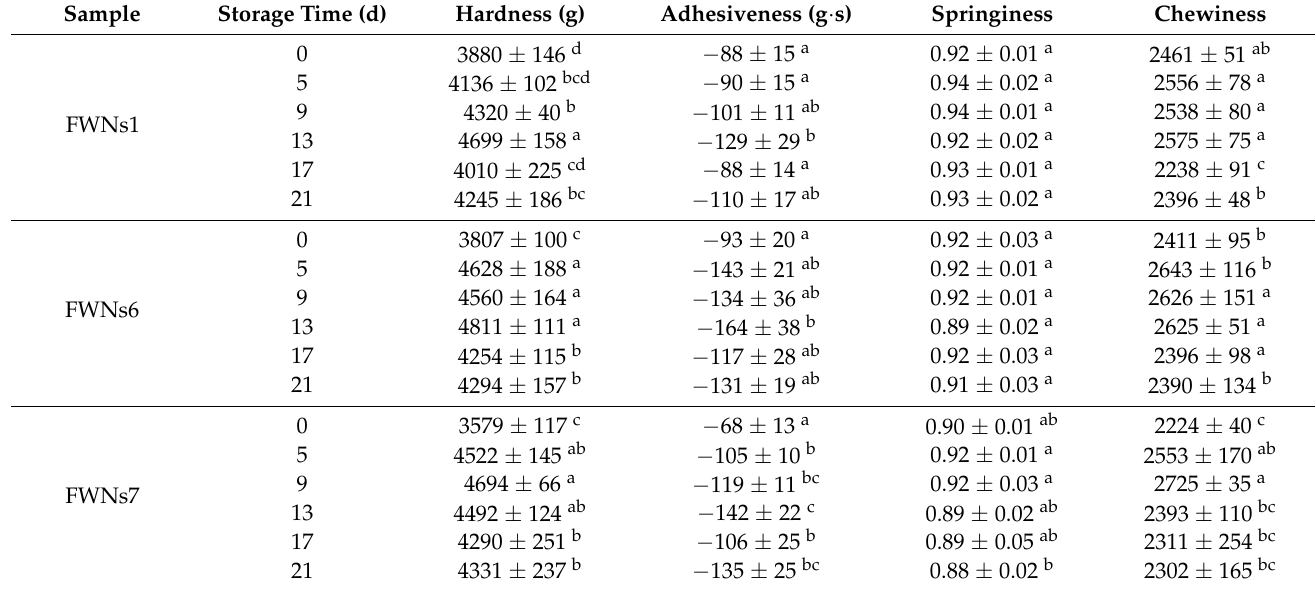
Table 2. Texture changes of FWNs1, FWNs6 and FWNs7 during